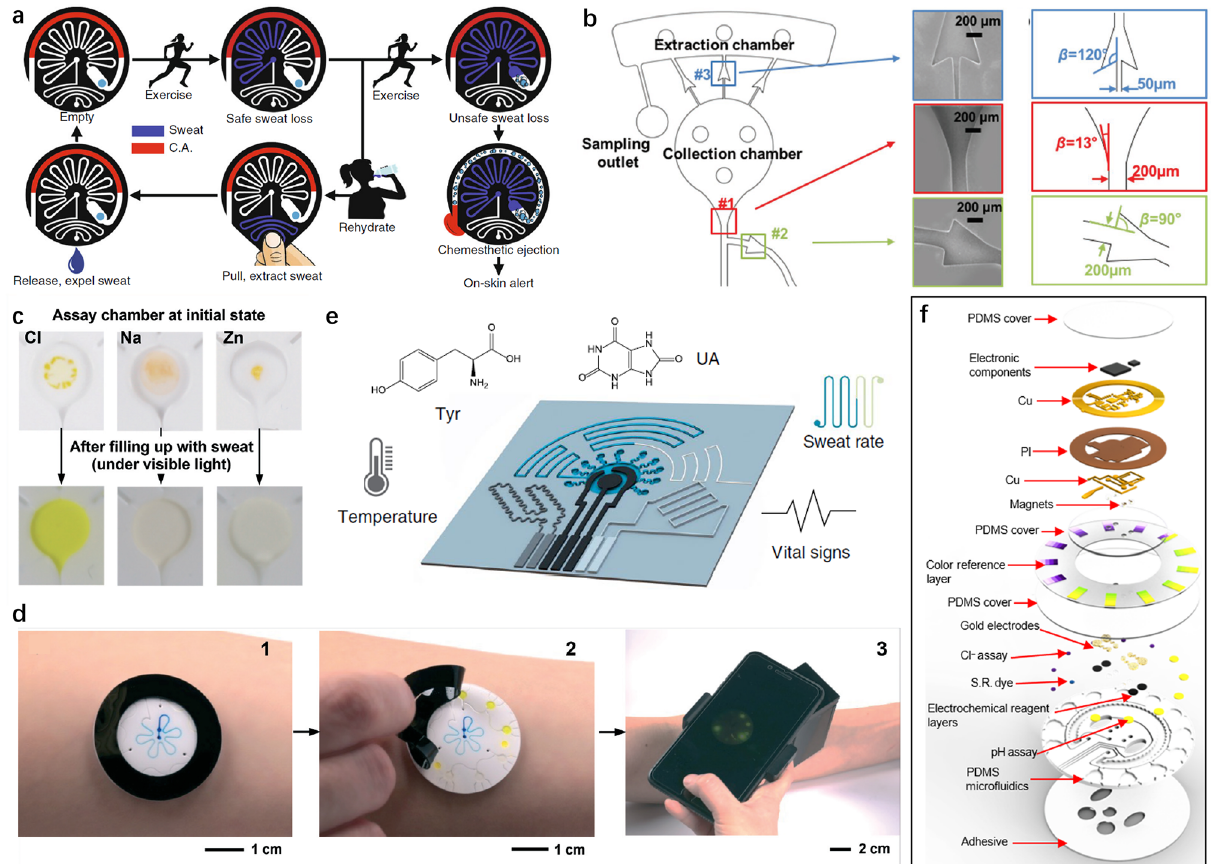
Fig. 35 Soft sweat sensor. a Schematic flow of reusable microfluidic channels operation. C.A. = Chemesthetic agent. Reproduced with permis- sion [406]. Copyright (2019), Nature Publishing Group. b Schematic illustration of a unit cell, containing a collection chamber, extraction cham- ber, sampling outlet, and three CBVs. SEM images of CBVs. Sketch of CBVs with indicated channel width and diverging angle. Reproduced with permission [409]. Copyright (2017), Wiley–VCH. c Photographs of the microreservoirs for the assays before (upper) and after (lower) fill- ing with sweat collected by microfluidic channels under visible light illumination. d Procedure for performing a fluorometric assay: 1. Collecting sweat by skin-interfaced microfluidic device 2. Peeling away the black shield 3. Capturing a photograph of the device using a smartphone with the optics module. Reproduced with permission [412]. Copyright (2018), Royal Society of Chemistry. e Multiple functions of the laser-engraved sensor: sweat UA and Tyr detection, sweat rate estimation, temperature sensing, and vital-sign monitoring. Reproduced with permission